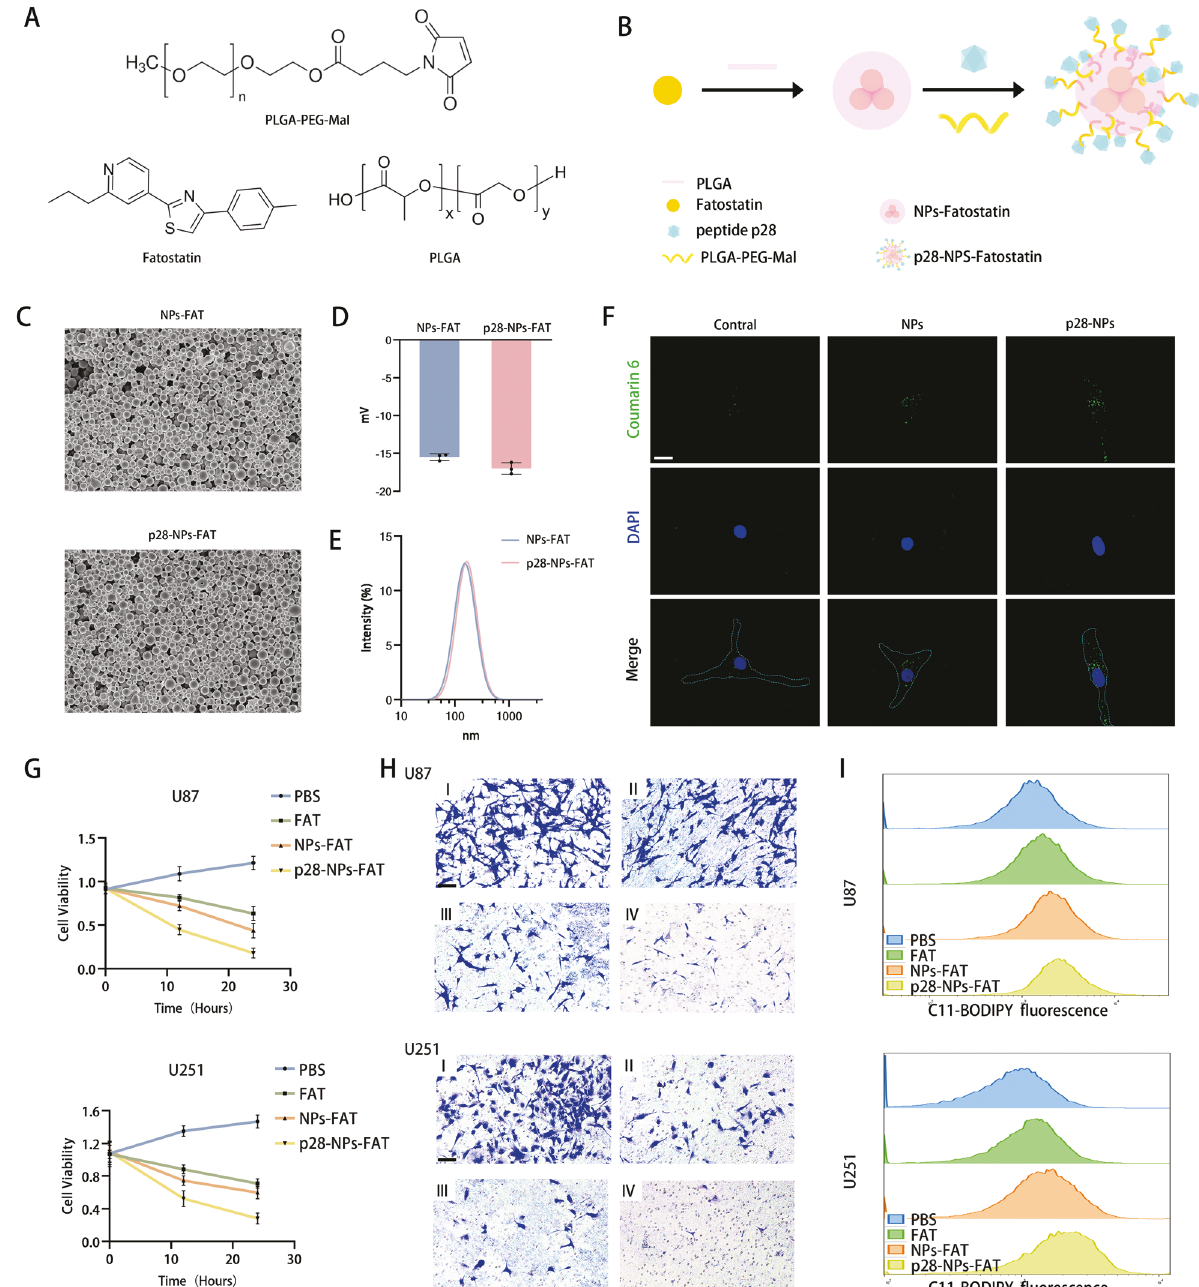
Fig. 7 Engineered fatostatin NPs enhance the antitumor effects of fatostatin through targeted delivery to GBM cells. A The chemical formula of fatostatin, PLGA, and PLGA-PEG-MAL. B Schematic diagram of nanoparticle synthesis. C SEM showed the morphology of NPs-FAT (loaded with fatostatin) and p28-NPs-FAT. D The ζ -potential of NPs-FAT and p28-NPs-FAT. E The mean hydration diameter of NPs-FAT and p28- NPs-FAT. F Cellular uptake assay using free C6, NPs encapsulated C6, and p28-NPs encapsulated C6. G CCK-8 assays showed the cell viability (absorbance value at 450 nm) of U87 and U251 cells after treatment with PBS, fatostatin (FAT), NPs-FAT, or p28-NPs-FAT. H The invasion ability of U87 and U251 cells after treatment with PBS (I), FAT(II), NPs-FAT(III), or p28-NPs-FAT (IV). I The ROS levels of U87 and U251 cells after treatment with PBS, FAT, NPs-FAT, or